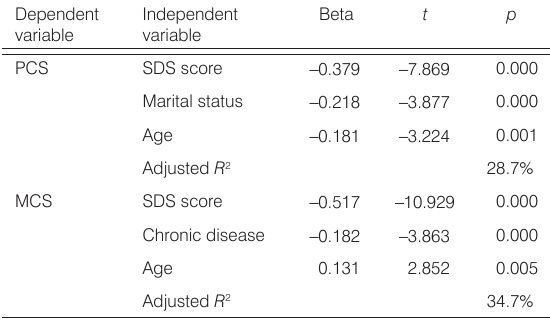
Table 4. Multiple linear regression analyses predicting PCS and MCS of SF-36 in 313 older